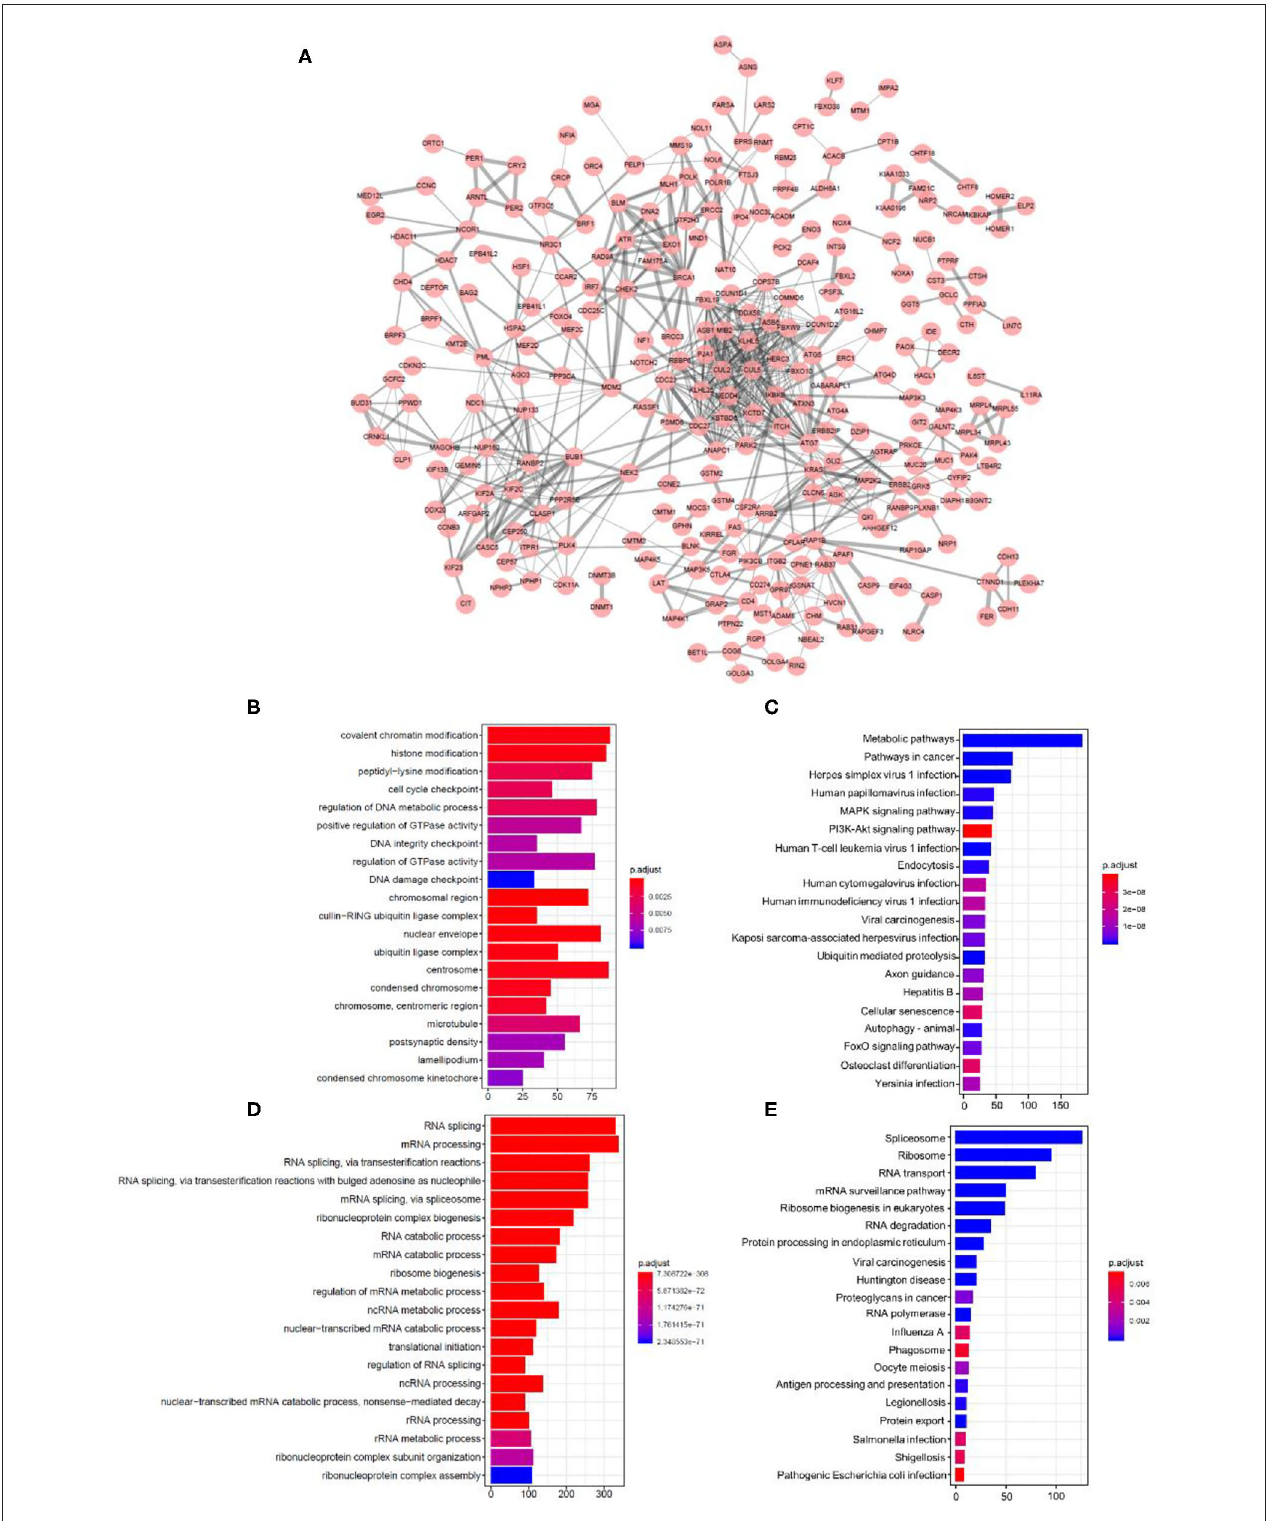
FIGURE 5 | Construction of the protein–protein interaction network and functional enrichment analysis. (A) Protein–protein interaction network of spliced genes affected by RBP mutations. Red dots represent each spliced gene. Line thickness represents the strength of interaction. (B–E) GO and KEGG analysis outcomes of RBPs and spliced genes. The top 20 most significant enriched pathways were exhibited in a bar plot. (B,C) Enriched pathways in GO analysis, (B) KEGG analysis, and (C) spliced genes regulated by RBPs. (D,E) GO, (D) KEGG, and (E) enrichment analysis outcomes of RBPs.